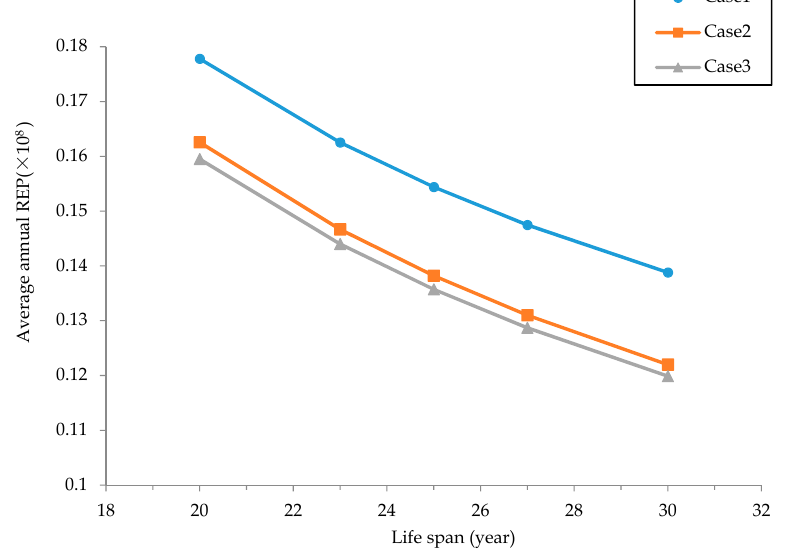
Figure 12. E ff ect of life span on average annual REP. Energies 2019 , 12 , x FOR PEER REVIEW Figure 12. Effect of life span on average annual REP.